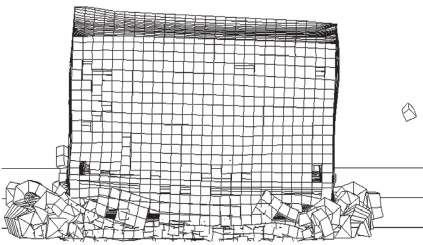
Figure 7: The flying stone element generated under the 26th working